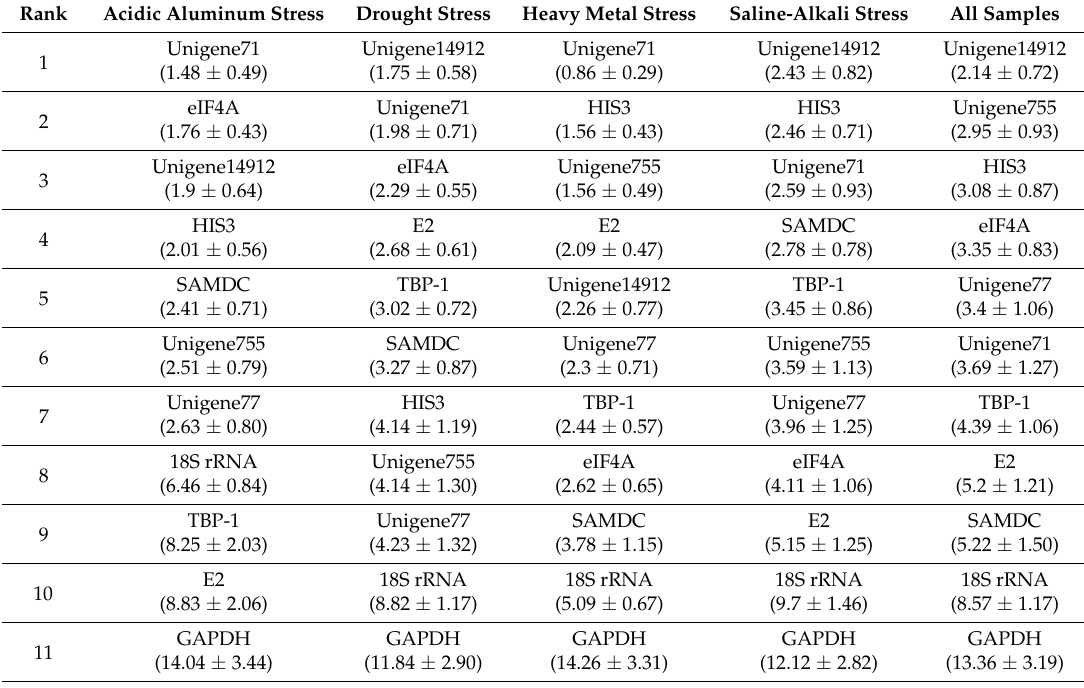
standard deviation (SD).